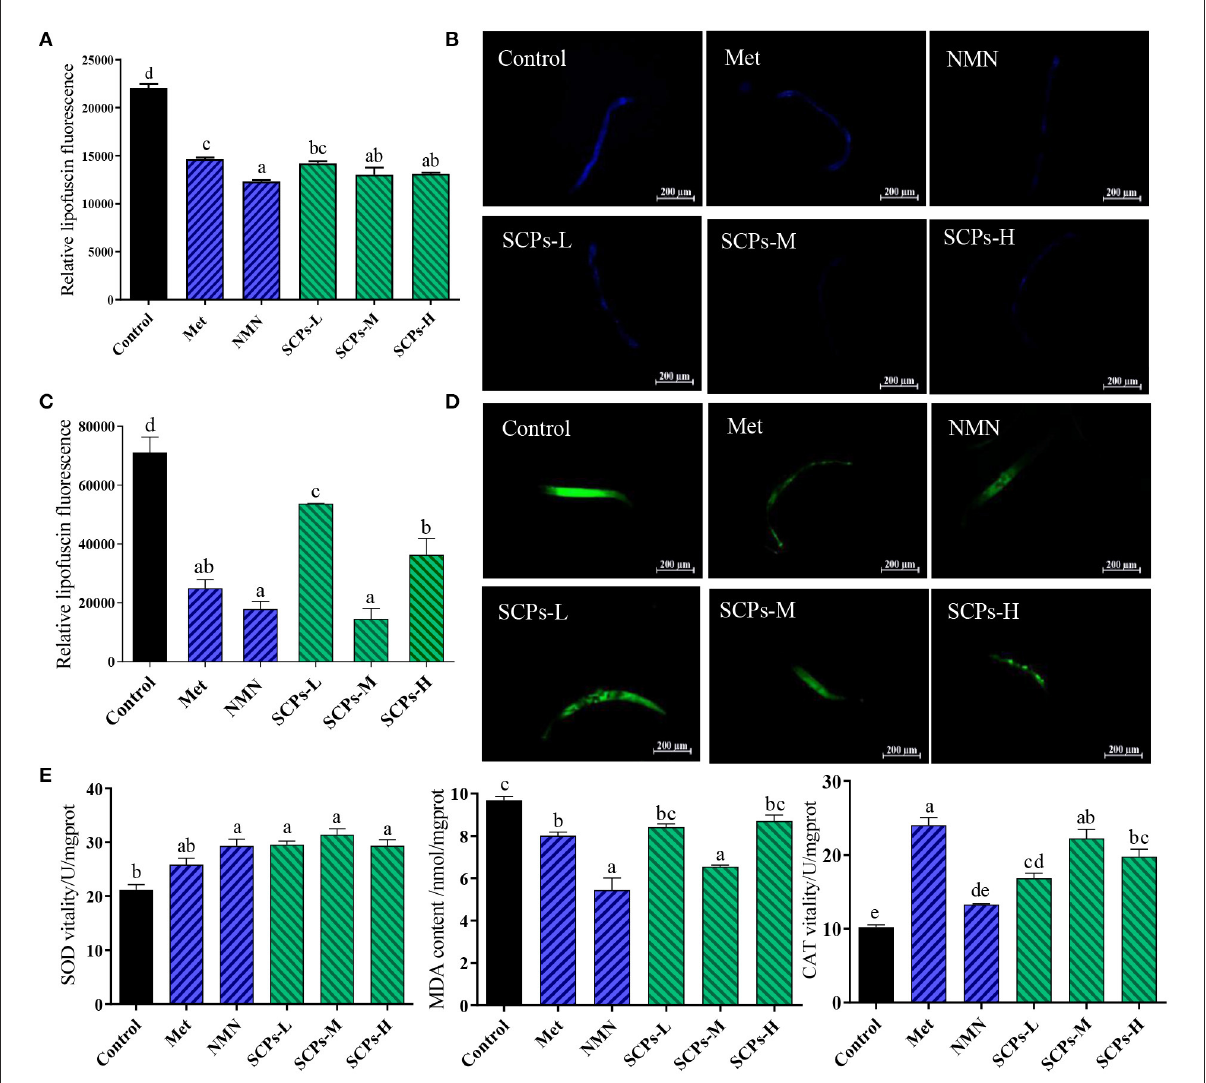
FIGURE4 Effect of SCPs on lipofuscin, ROS accumulation, and internal oxidation in N2. (A) The bar shows a gray value on lipofuscin in N2 after treatment with SCPs. (B) The typical fluorescent pictures of lipofuscin. (C) The bar shows a gray value on ROS in N2 after treatment with SCPs. (D) The typical fluorescent pictures of ROS accumulation. (E) The effects of SCPs on SOD, MDA, and CAT of N2 under normal conditions. Different letters correspond to statistically significant differences ( p < 0.05) between